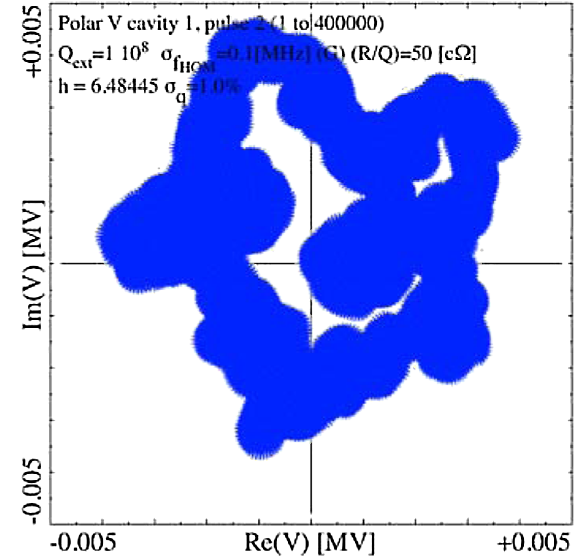
FIG. 66. (Color) Polar display of the cavity voltage above.